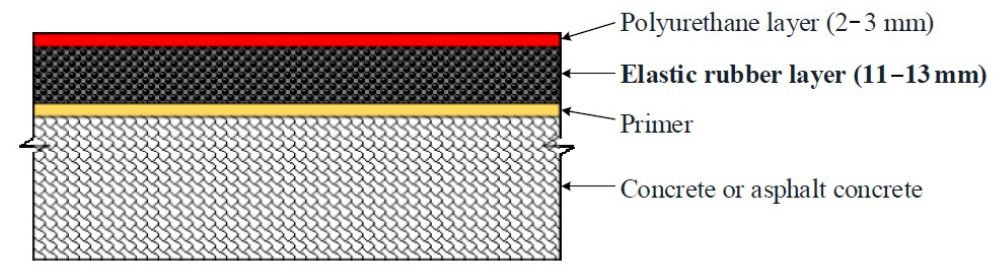
Figure 1. Structure of a synthetic sports surface.